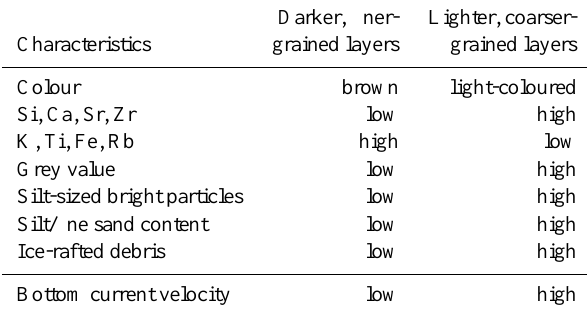
Table 2. Characteristics of seasonally deposited darker, finer- grained layers and lighter, coarser-grained layers. Elements were measured using an ITRAX X-ray fluorescence scanner (see also Figs. 4–6).